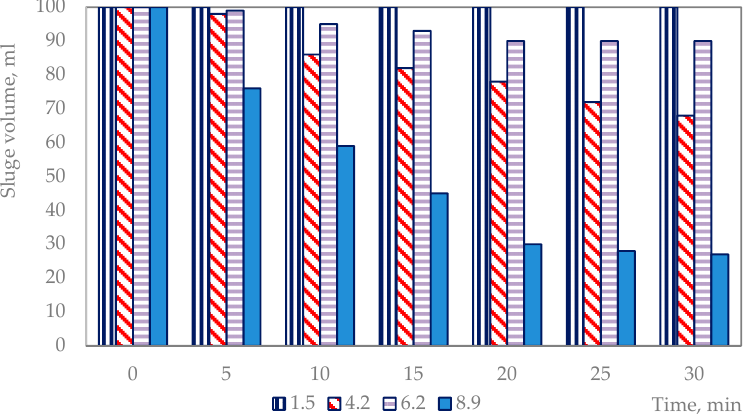
Figure 2. Settleability of the sludge generated before and after treatment with lime at different pH values.